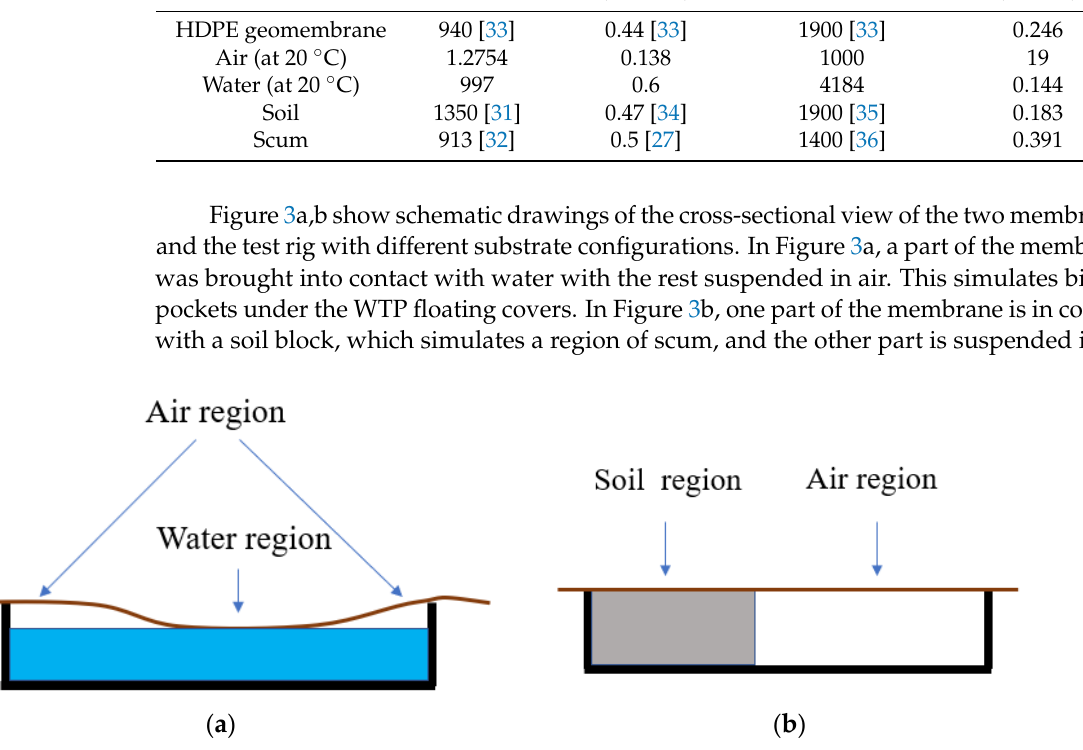
Figure 3. Side profiles of test rig. ( a ) membrane on air and water; ( b ) membrane on air and soil.